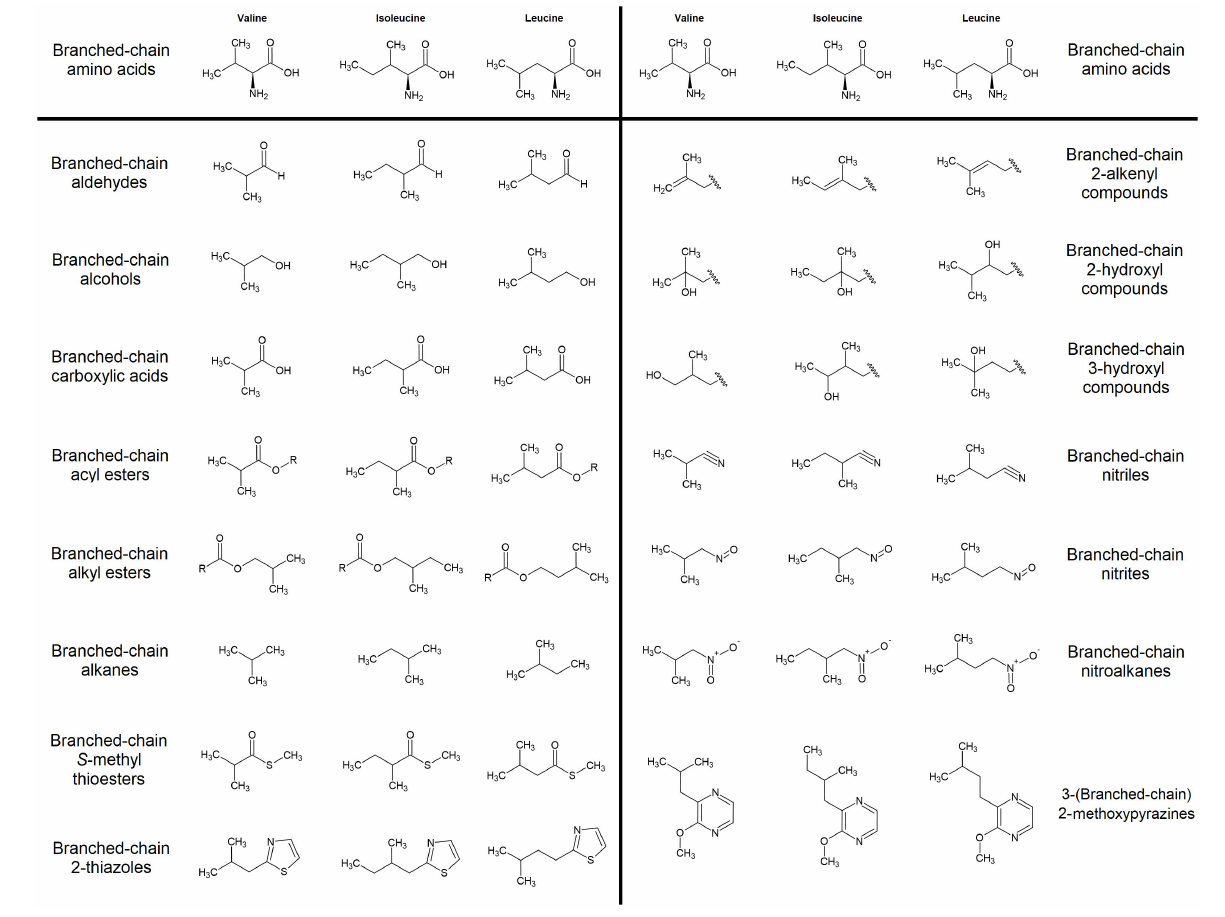
none of which are mutually exclusive with any of the